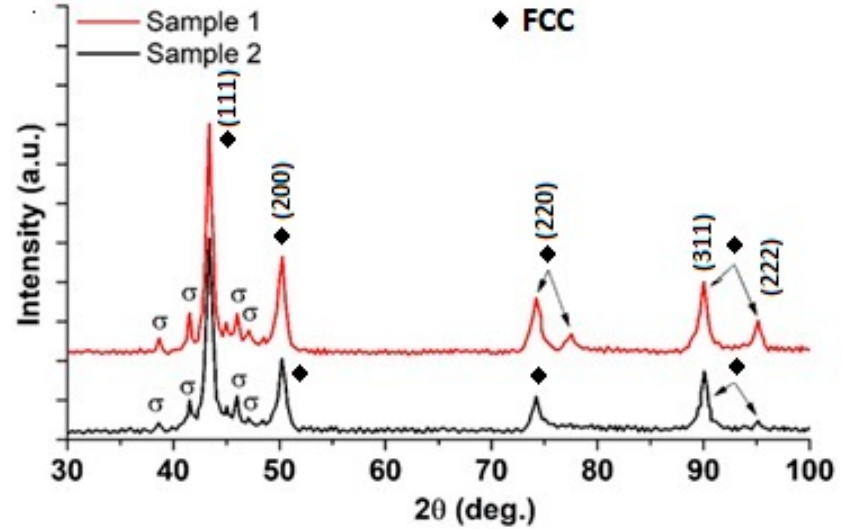
Figure 2. XRD patterns of the investigated